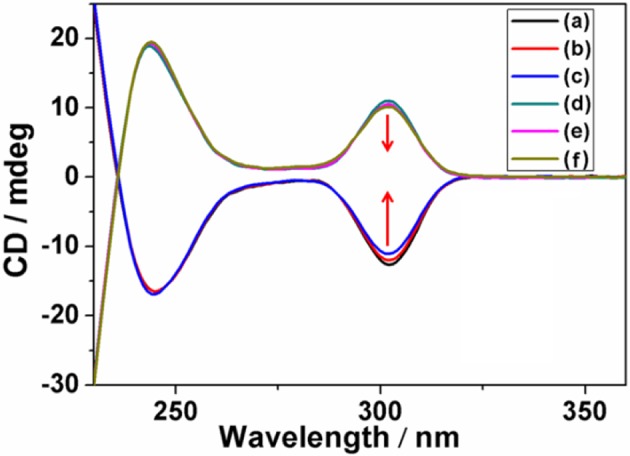
Dynamic CD spectra of (Sp-D)-GP5 [(A–C) 8 μM in H2O] and (Rp-D)-GP5 [(D–F) 8 μM in H2O] at 298, 313, and 323 K, respectively.